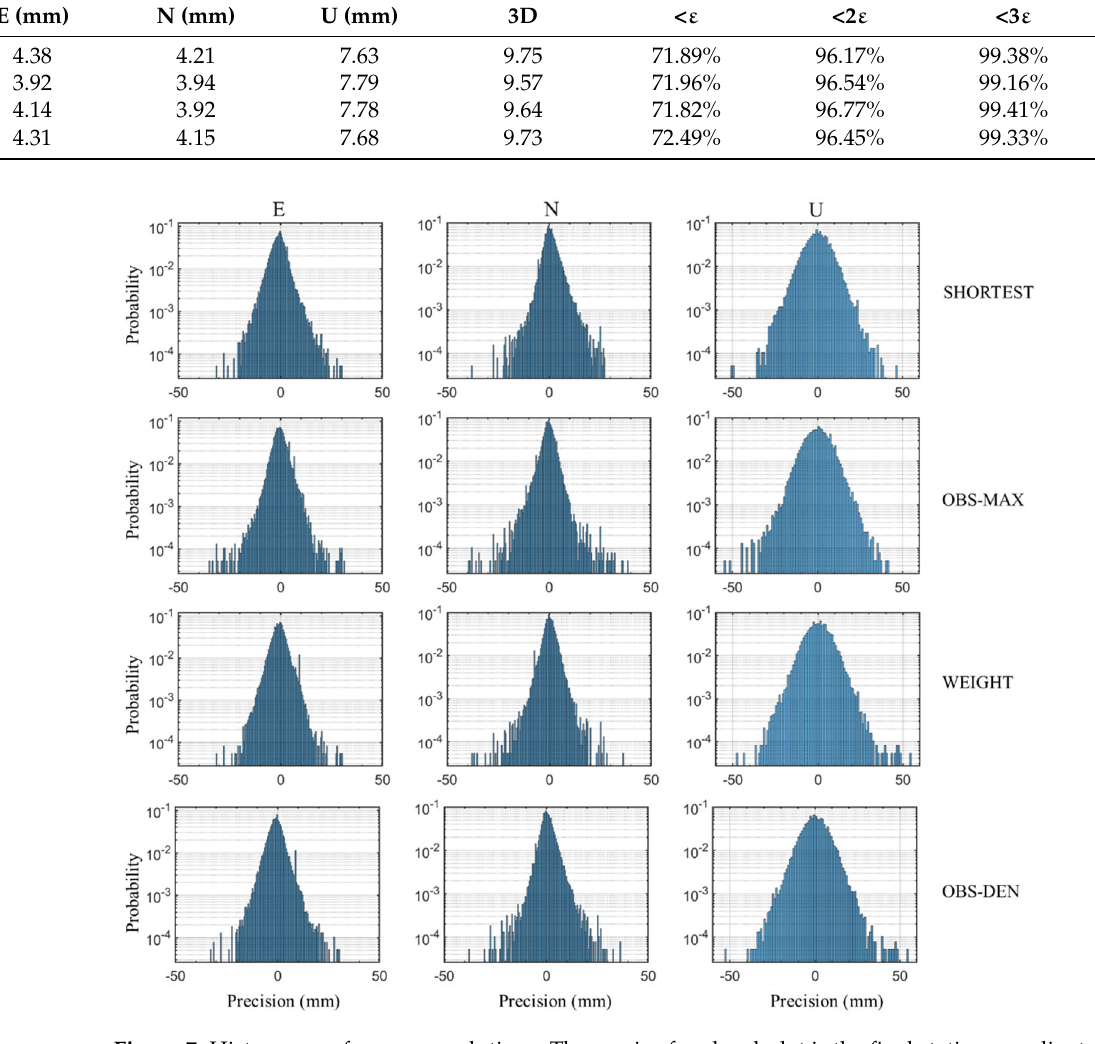
Figure 7. Histograms of one ‐ year solutions. The x ‐ axis of each subplot is the final station coordinate accuracy in millimeters, and the interval of each bin is 1 mm. The y ‐ axis of each subplot, which is on a logarithmic scale, represents the quotient of the number of stations accommodated in each bin and the total number. The columns from left to right denote the East (E), North (N), and Up (U) component, respectively. The four methods from top to bottom are SHORTEST, OBS ‐ MAX, WEIGHT, and OBS ‐ DEN, respectively.